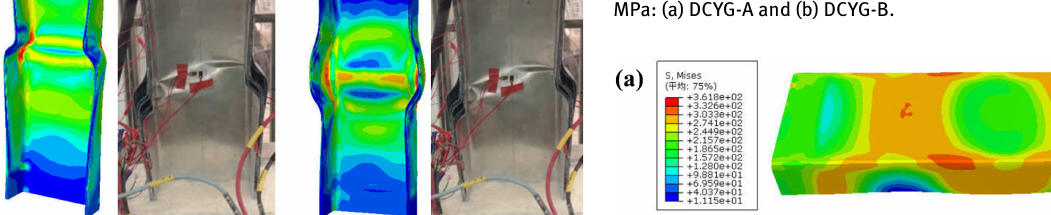
Figure 11: Stress area distribution of compression columns at 300